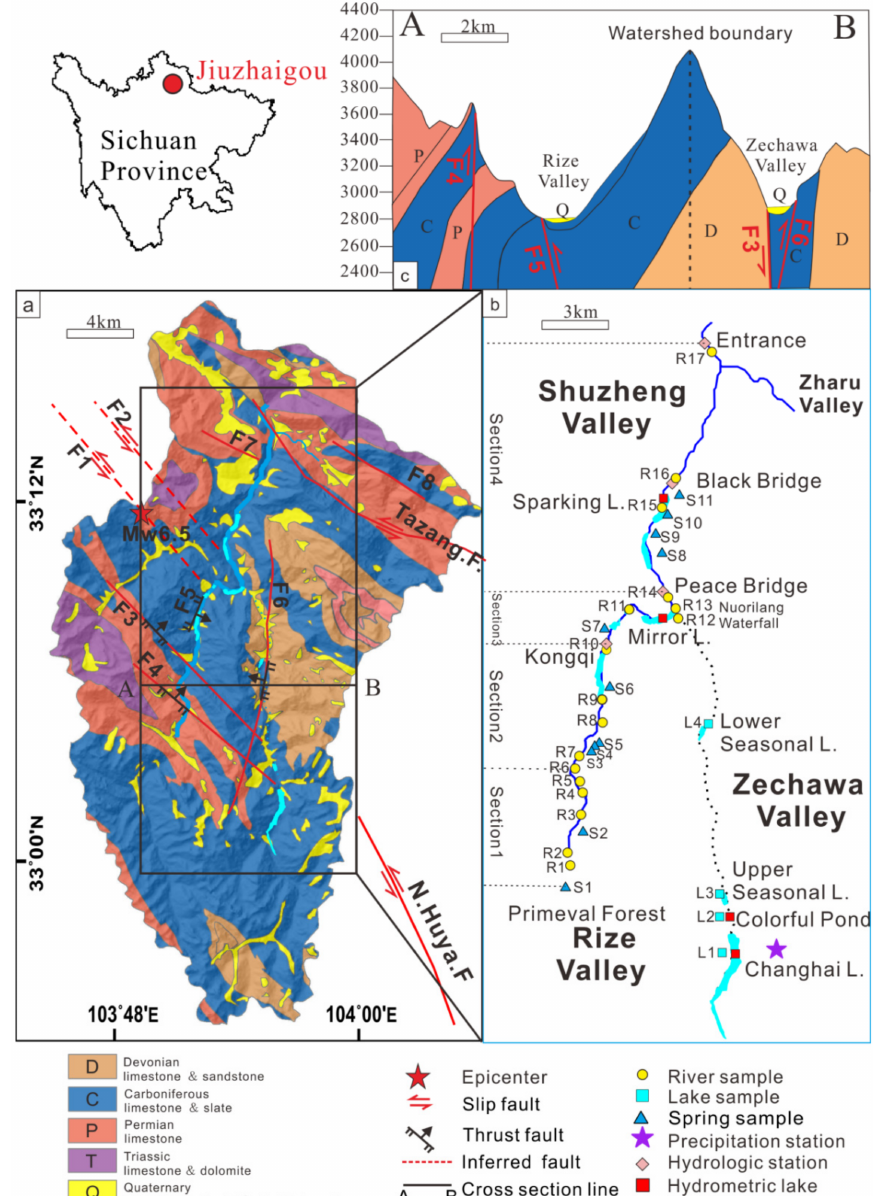
Figure 2. ( a ) Sketch map of Jiuzhaigou geological structure modified from the work of Lugli, 2017 [37]: ( b ) sampling sites in the ( c ) Jiuzhaigou section map. F1 is a seismogenic fault, and F2 is a secondary coseismic fault in the core predicted by Li and Wang [26,36]. F3–F8 are foregone thrust faults, referred to as the Yingzhaodong Fault (F3), the Changhai Lake–Hanging Spring Fault (F4), the Jiuzhaigou Fault (F5), the Zechawa Fault (F6), the Heye Fault (F7), and the Zharu Fault (F8),